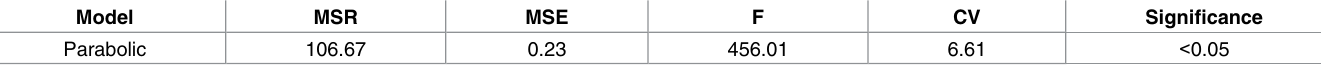
Table 2. An example of F value for the significance of the regression equation.